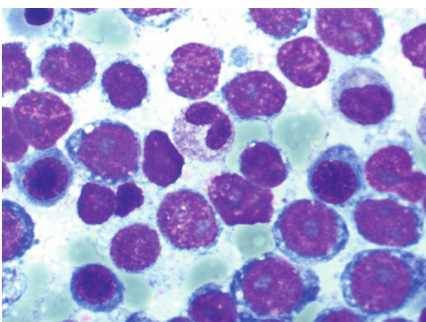
Figure2:Aspiratesmear,Wright-Giemsastain,100ximageshowing the neoplastic lymphoid cells with basophilic cytoplasm, cytoplas- mic vacuoles, and large prominent nucleoli.